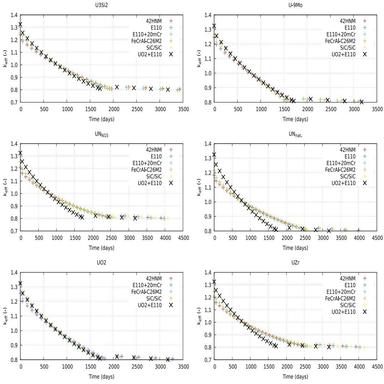
Multiplication factors of the fuel types with optimized fuel enrichment based on the enrichments in